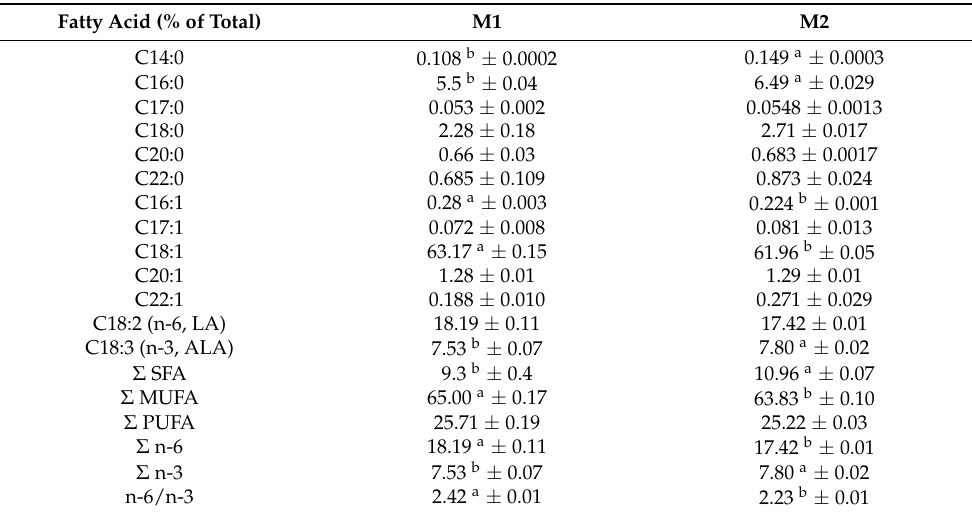
Table 1. Fatty acid composition (% of total fatty acids) of M1 (Old Polish) and M2 (Bordeaux) marinades (mean values ± standard error of the